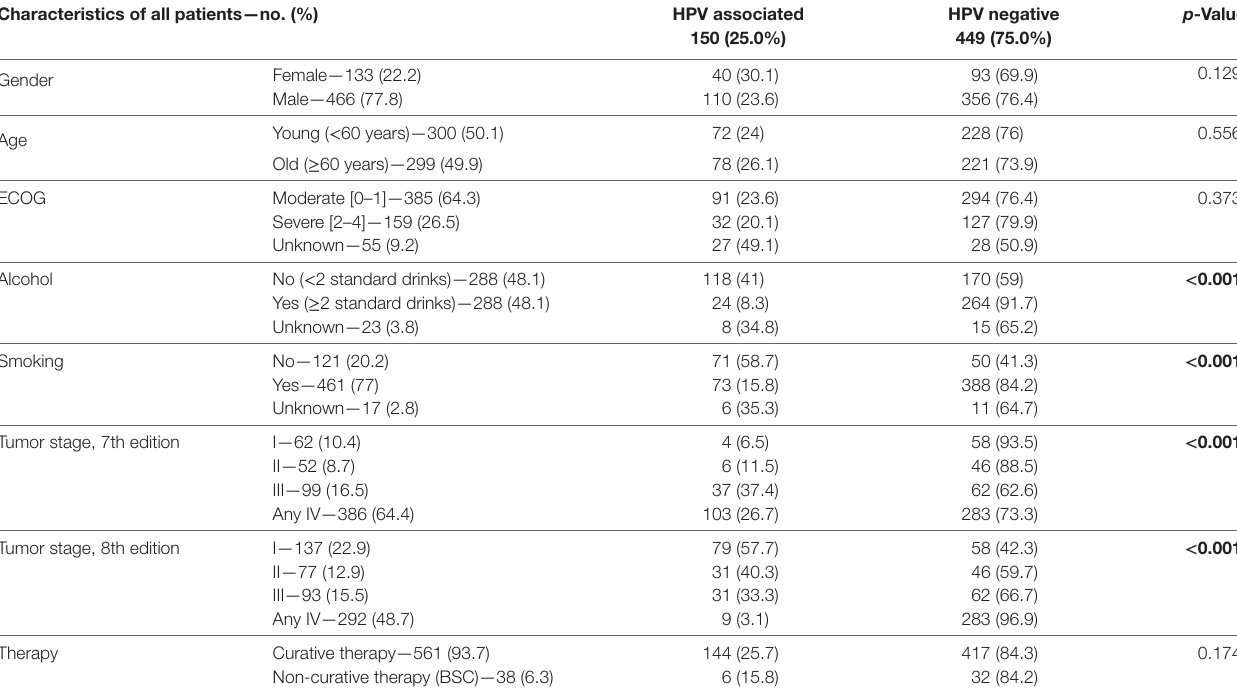
taBLe 1 | Characteristics of 599 patients with oropharyngeal cancers and known human papilloma virus (HPV) status. Characteristics of all patients—no.